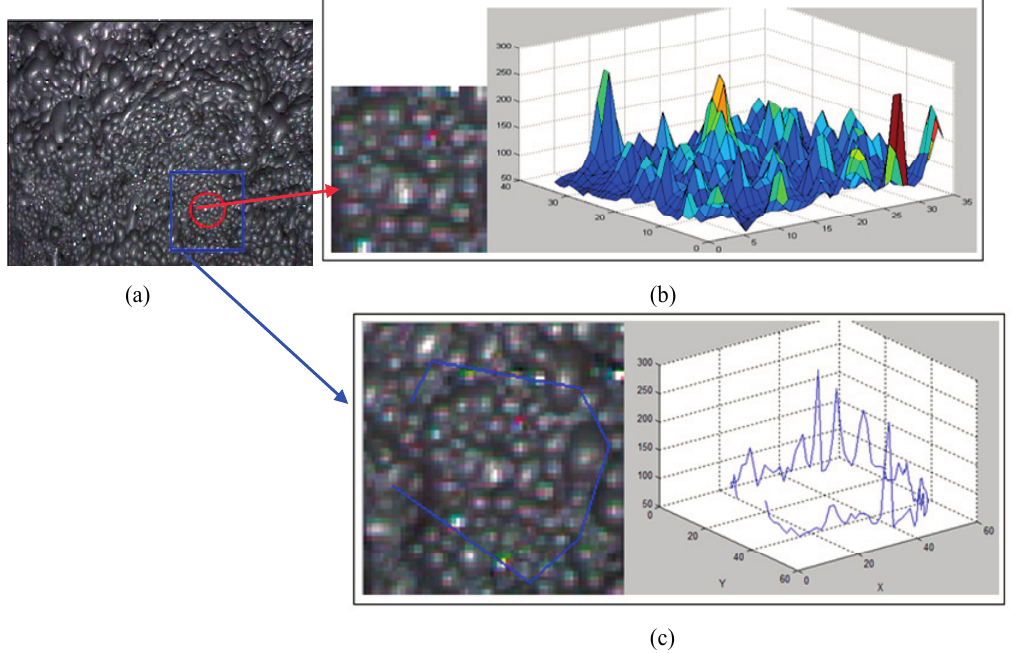
Figure 2. Gray value characteristic of the image of small bubbles. ( a ) A small bubble image; ( b ) left : a part of the image (a); right : the 3D surface of the left image; ( c ) left : small bubbles and the profile line; right : the gray level histogram of the profile corresponding to the left image.